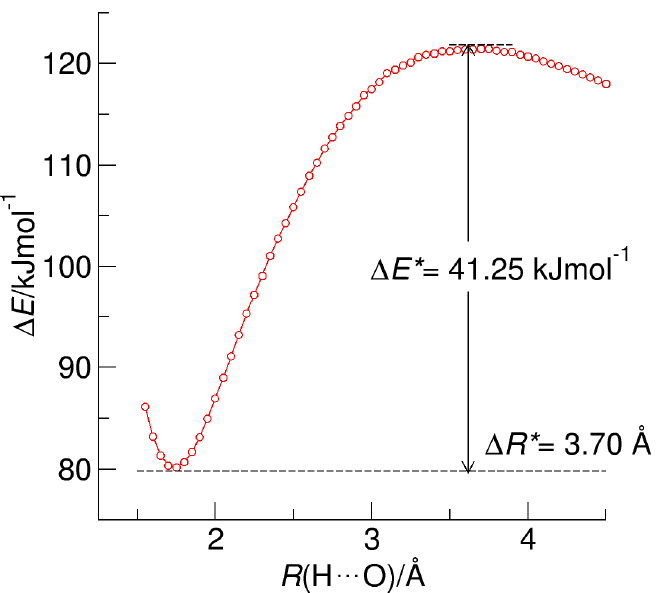
Figure 4. Potential energy curve for the hydrogen-bonded cationic dimer (HOOC–CH 2 –py + ) 2 , as calculated at the B3LYP–D3/6–31+G* level of theory, relaxing the structure for each hydrogen bond length R (H···O). The curve progression is characterized by a clear minimum energy Δ E of about 80.17 kJmol − 1 at the equilibrium bond distance R (H···O) = 1.738 Å. The dissociative energy profile shows a pronounced binding well with respect to the dissociated anions and effective equilibrium well depths Δ E * = 41.25 kJmol − 1 at Δ R * = 3.70 Å with respect to the transition state. 3.5. Kinetically Stabilized Cationic Dimers (HOOC–(CH 2 ) n –py + ) 2 with n = 1–5 For the dimers (HOOC–(CH 2 ) n –py + ) 2 with n = 1–5, we show that Δ E strongly decreases from 80.2 kJmol − 1 ( n = 1) down to –2.5 kJmol − 1 ( n = 5), reaching already negative